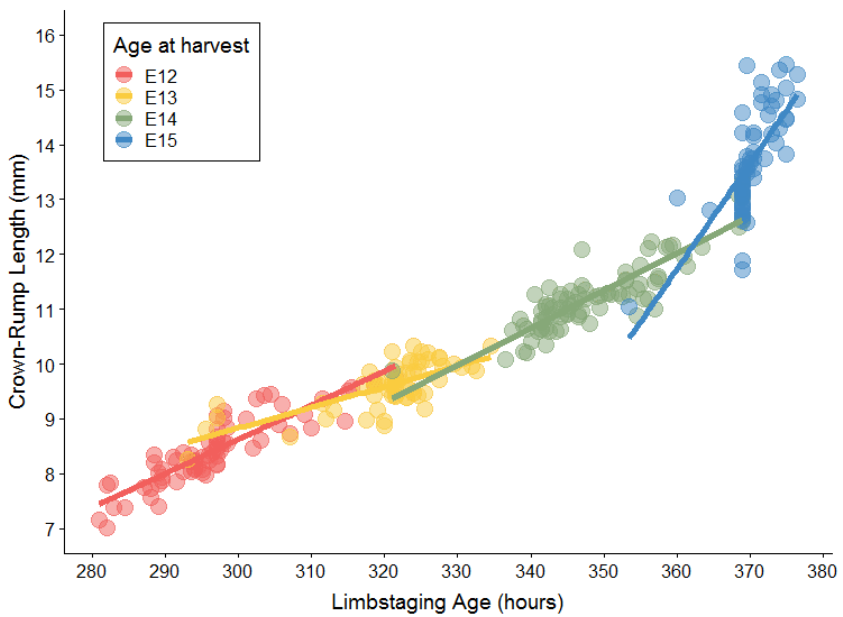
Figure 5. Graph of crown–rump length and limbstaging age. Dots represent individual specimens and are colored according to age at